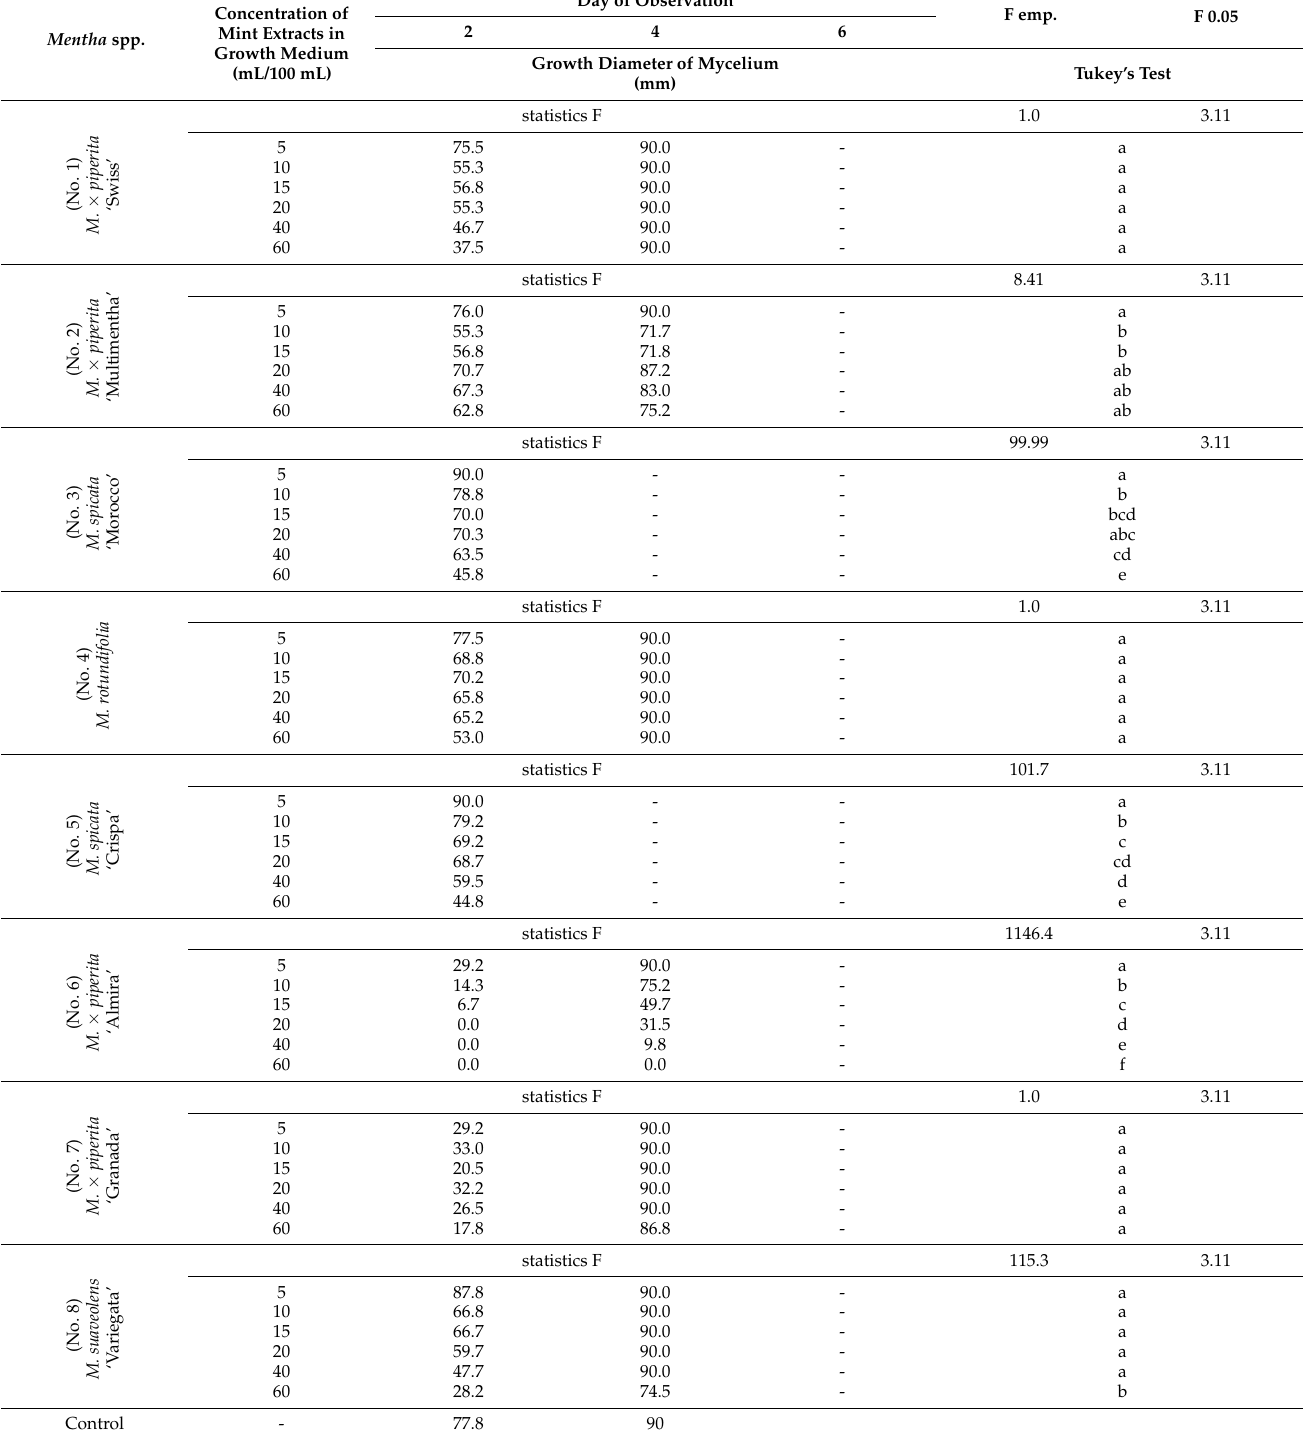
Table 1. Growth diameter of T. viride on a medium containing various amounts of mint